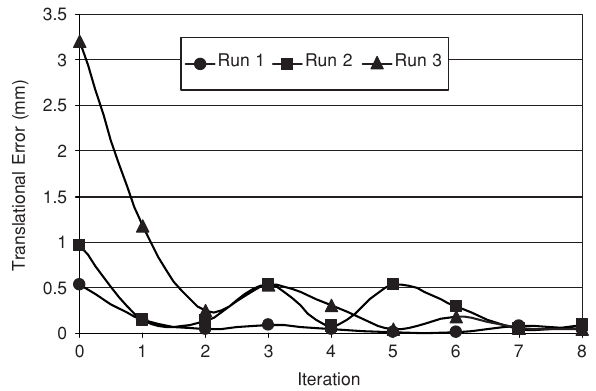
Figure 4 Rotational errors versus iteration